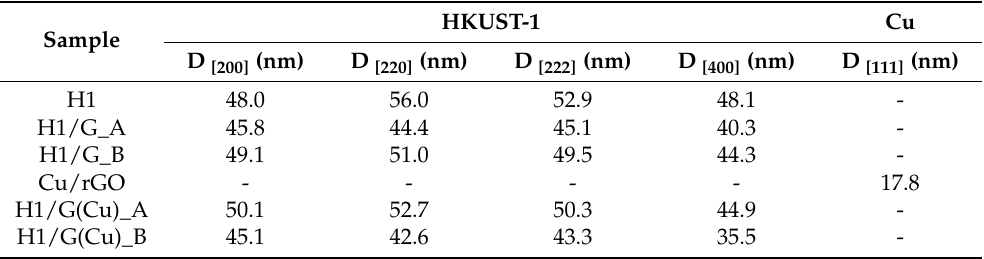
Figure 1. XRD patterns of the HKUST-1/GO composites (H1/G_A, H1/G_B, H1/G(Cu)_A, and H1/G(Cu)_B) and their components alone: HKUST-1 (H1), GO, and Cu/rGO. Table 1. The mean sizes of HKUST-1 and Cu crystallites in obtained